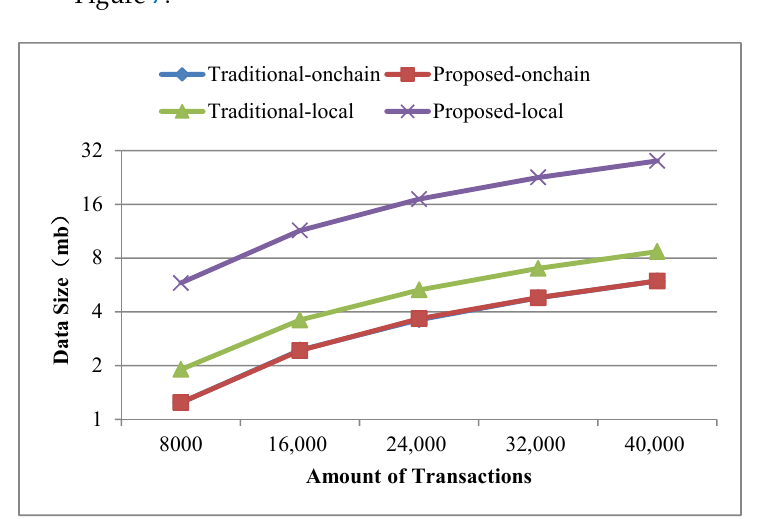
Figure 7. Data amount with different amount of